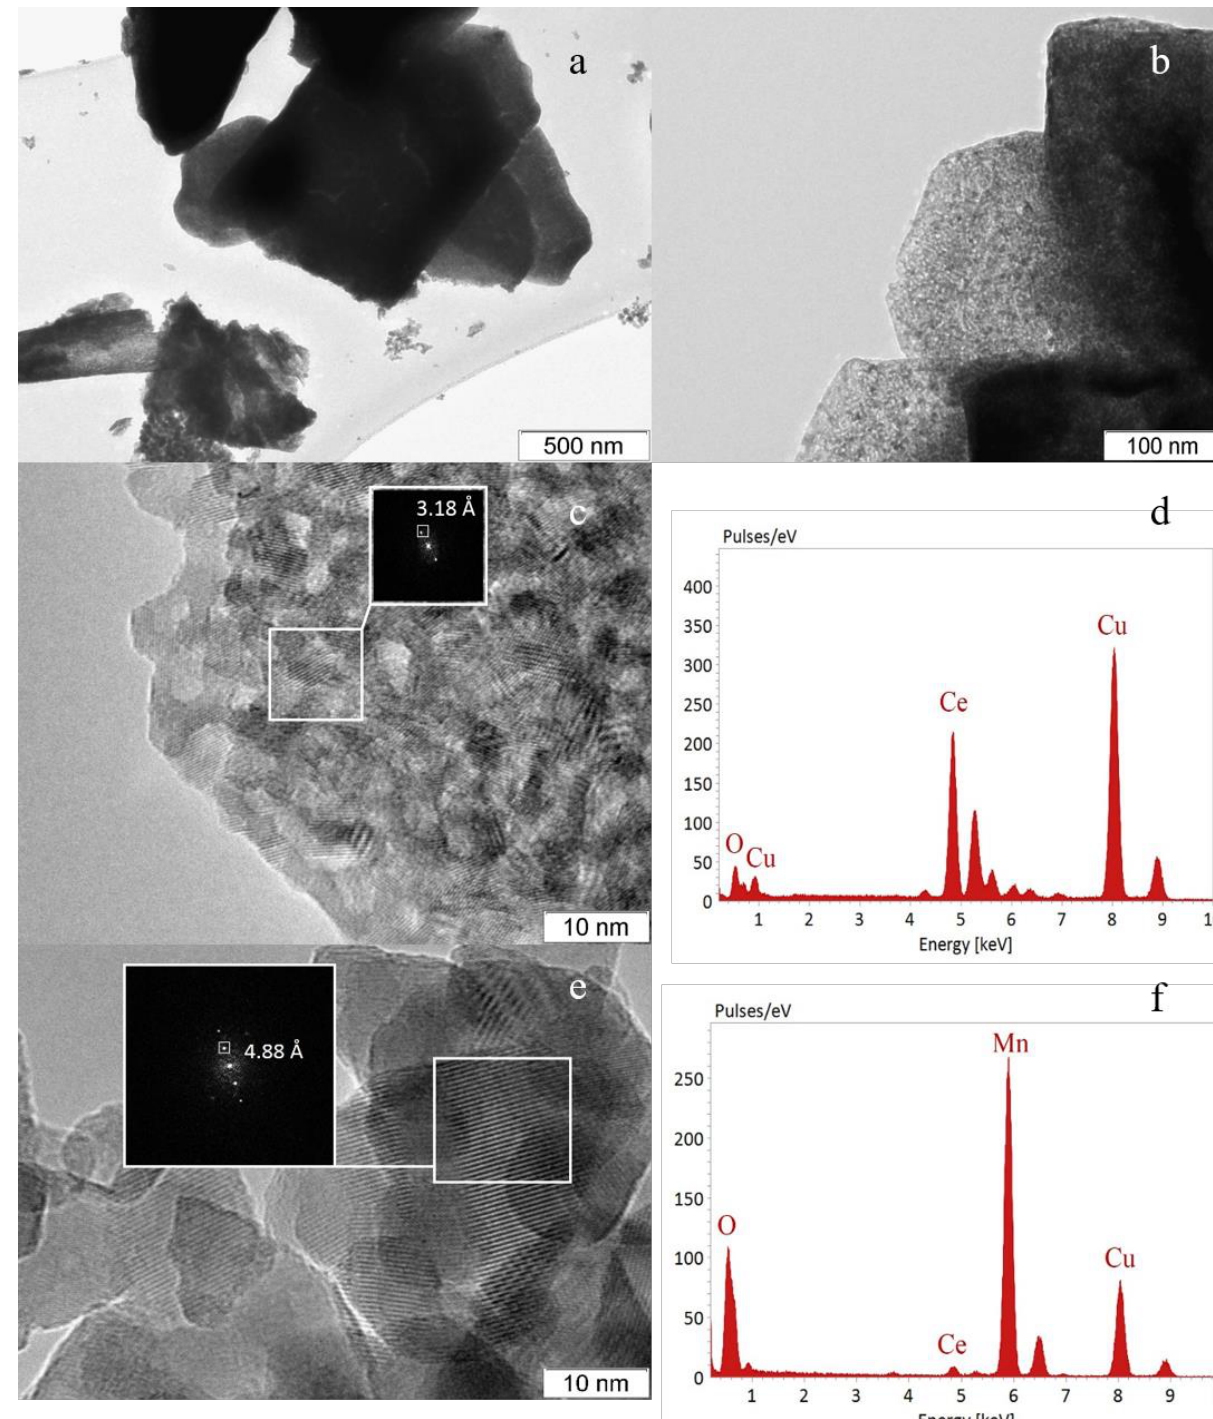
Figure 3. TEM images of Mn0.15Ce0.85 ( a , b , c , e ) and EDX spectra of Ce-rich ( d ) and Mn-rich ( f ) regions. In the case of catalysts with higher manganese content, Mn0.45Ce0.55 , there are two types of particles (Figure 4a,b). Particles of the first type have rounded shapes and sizes of 10–50 nm (Figure 4c). According to EDX analysis, there is the Mn-rich area; the Mn:Ce ratio is about 98:2 (Figure 4d). The interplanar distances of 4.85 Å are observed, which correspond to the (101) plane of Mn 3 O 4 or (200) plane of Mn 5 O 8 . The second type of particles are elongated, have a uniform shape (Figure 4a), and consist of dispersed